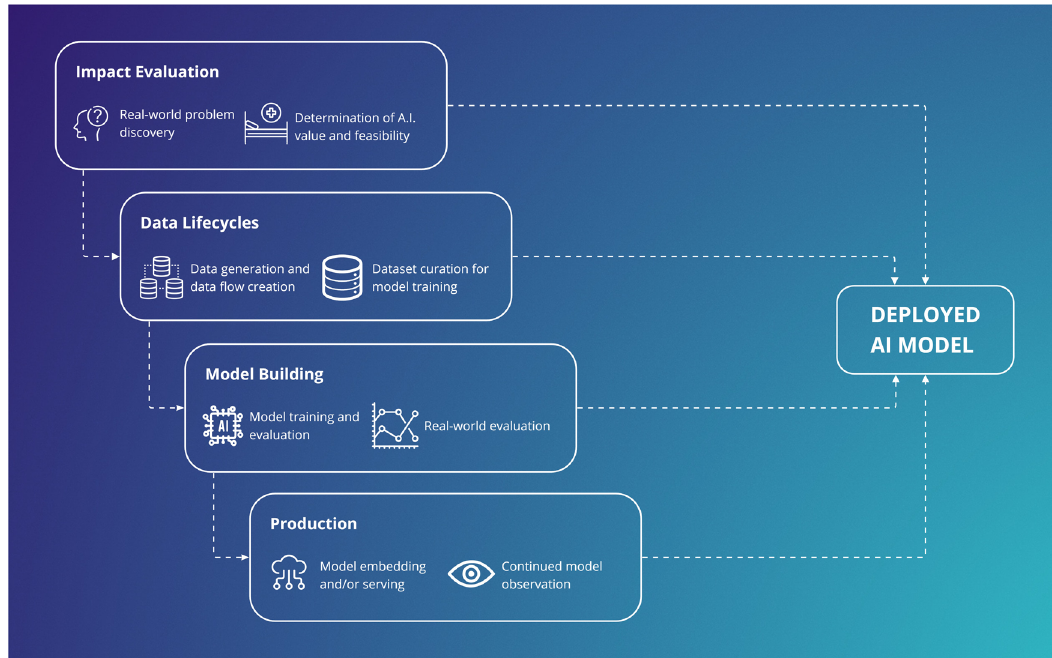
Fig. 1 Vertical integration across an arti fi cial intelligence supply chain. All supply chain components are essential for deployment and must work synergistically to support continued AI use. A focus on establishing a supply chain, has bene fi ts over an isolated focus on producing an accurate